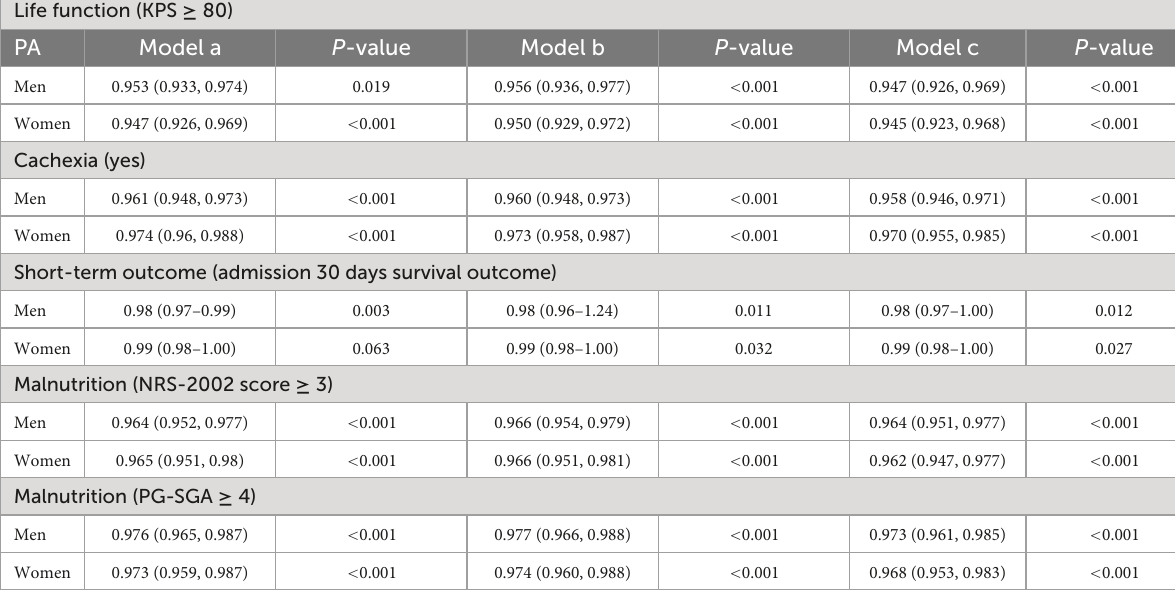
TABLE 2 Logistic regression analysis between PA and secondary